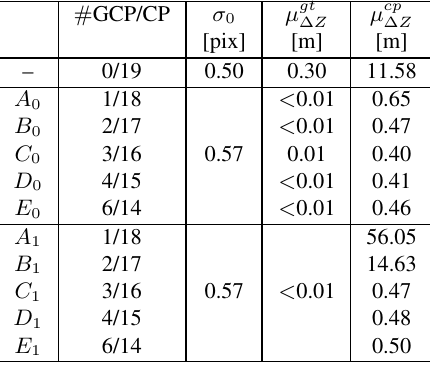
– mean discrepancies between BA-estimated and true Z-values on ∆ Z